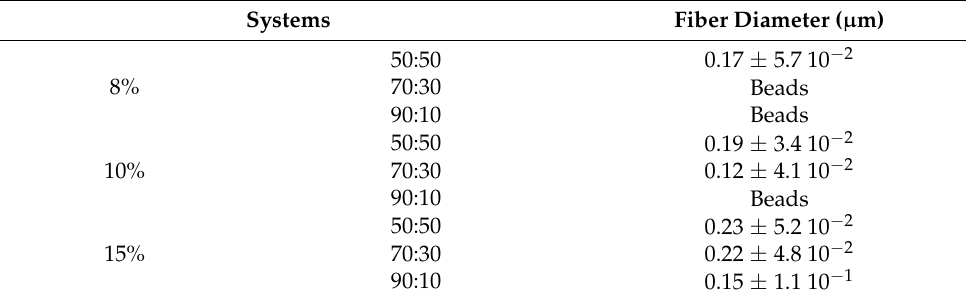
Figure 2. SEM images of electrospinning obtained from LSL:EC solutions at different concentrations and LSL:EC ratios: 50:50 LSL:EC ratio ( a ) 8% wt., ( b ) 10% wt, ( c ) 15% wt, 70:30 LSL:EC ratio, ( d ) 8% wt., ( e ) 10% wt., ( f ) 15% wt., 90:10 LSL:EC ratio, ( g ) 8% wt., ( h ) 10% wt, and ( i ) 15% wt. Table 2. Average fiber diameter values in the LSL/EC-electrospun nanostructures obtained.